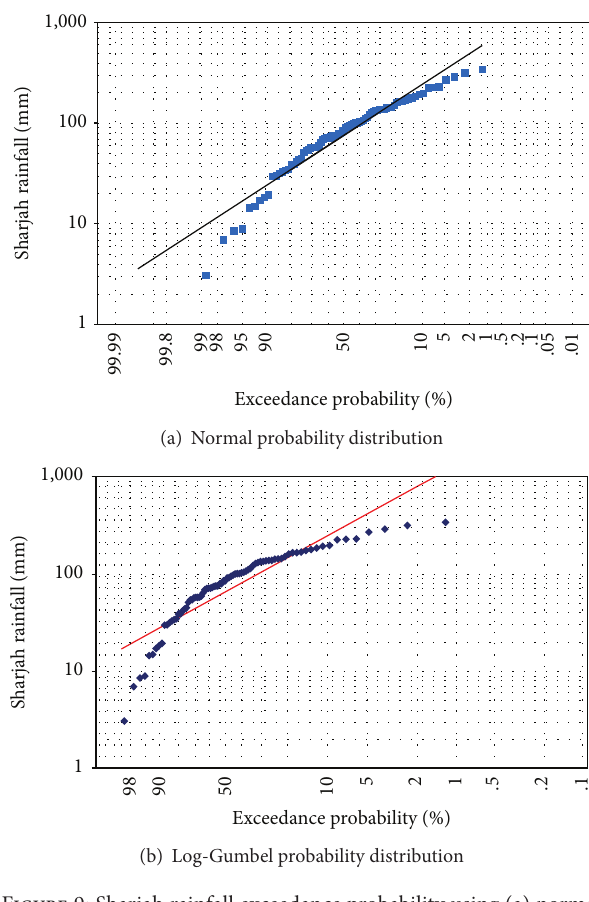
Figure 9: Sharjah rainfall exceedance probability using (a) normal probability distribution and (b) log-Gumbel probability distribu-